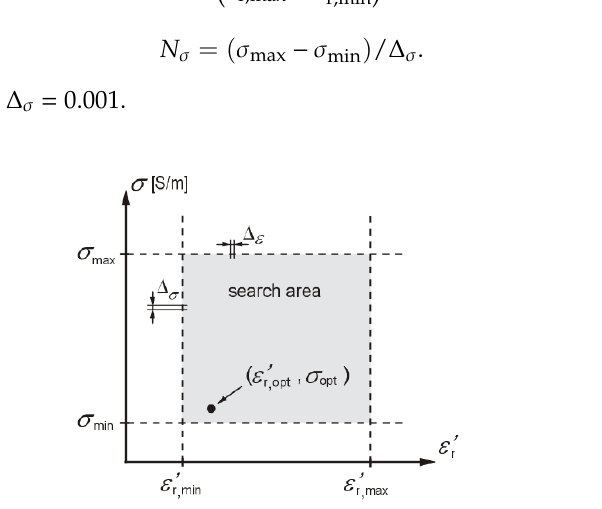
Figure 8. Boundaries of the search area when determining the equivalent electric parameters for heterogeneous material.